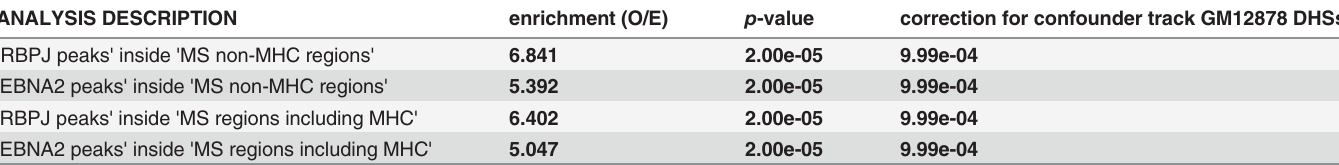
Table 1. EBNA2/RBPJ overlap with MS regions.